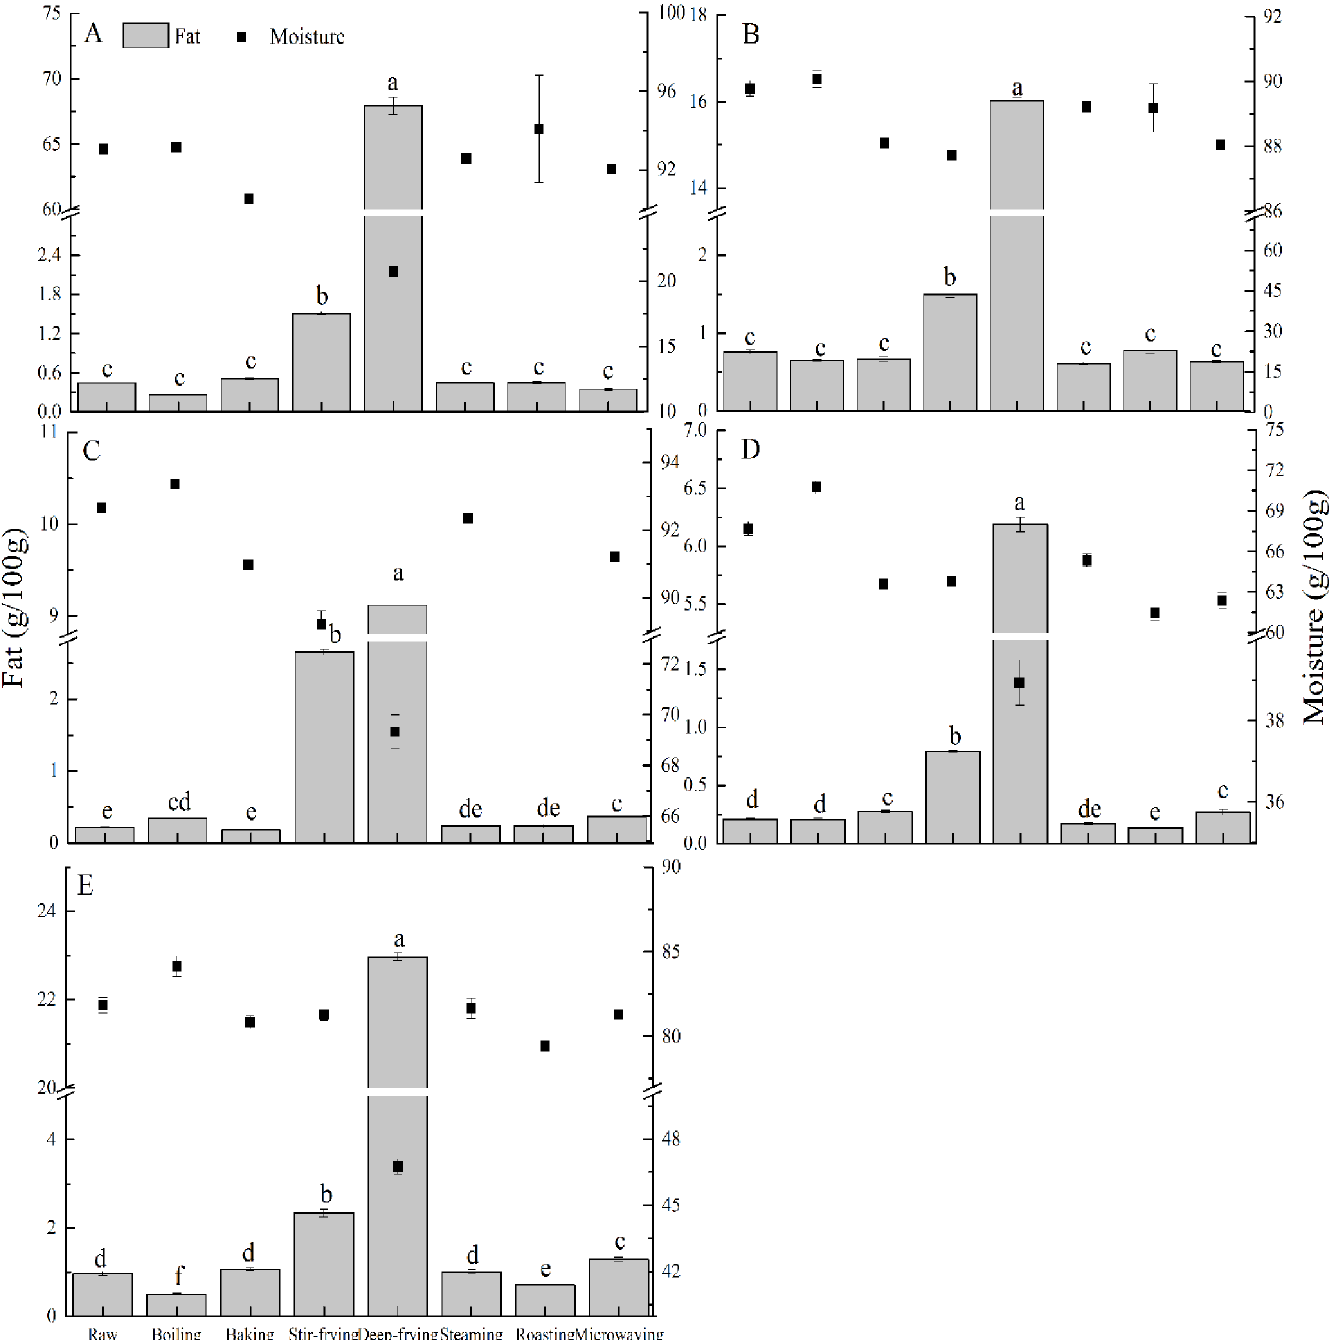
Fig 2. Fat (histogram) and moisture content ( ■ ) of crown daisy (A), unripehot pepper(B), onion (C), garlic (D) and red pepper(E). Values are mean ± SD (n (cid:21) 3). Bars of histograms (fat content) with same letters are not significantly different (p > 0.05).